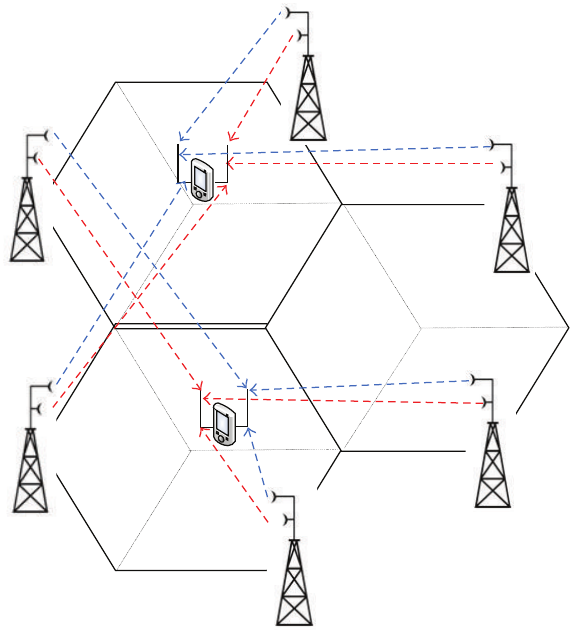
Figure 1: Cooperative MIMO